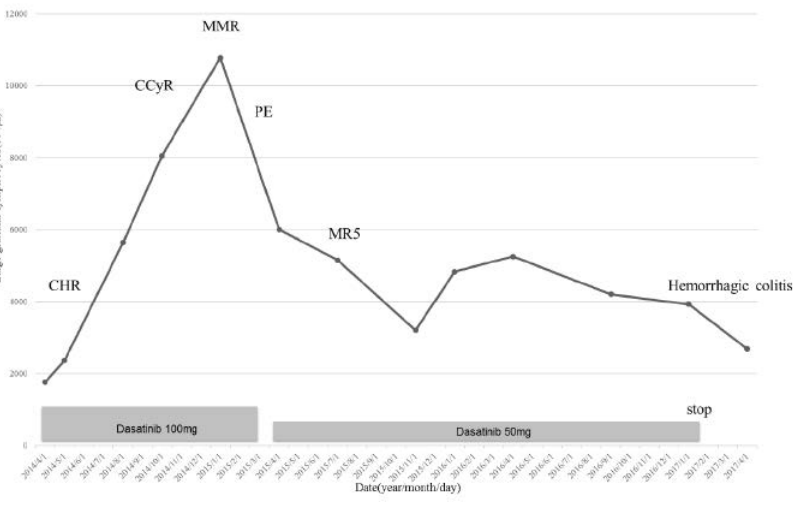
Figure 1. Patient’s clinical course. After treatment with dasatinib for chronic myeloid leukemia, the patient had a complete hematological response (CHR) within 1 month, a complete cytogenetic response (CCyR) within 6 months, and a major molecular response (MMR) within 9 months. However, 10 months after starting dasatinib, he developed pleural effusion (PE) and dasatinib was discontinued. The PE resolved immediately. Dasatinib was restarted but at a lower dose of 50 mg once a day. He retained the molec- ular response even after the dose reduction but he developed hemorrhagic colitis 32 months after starting dasatinib. Dasatinib was therefore stopped.